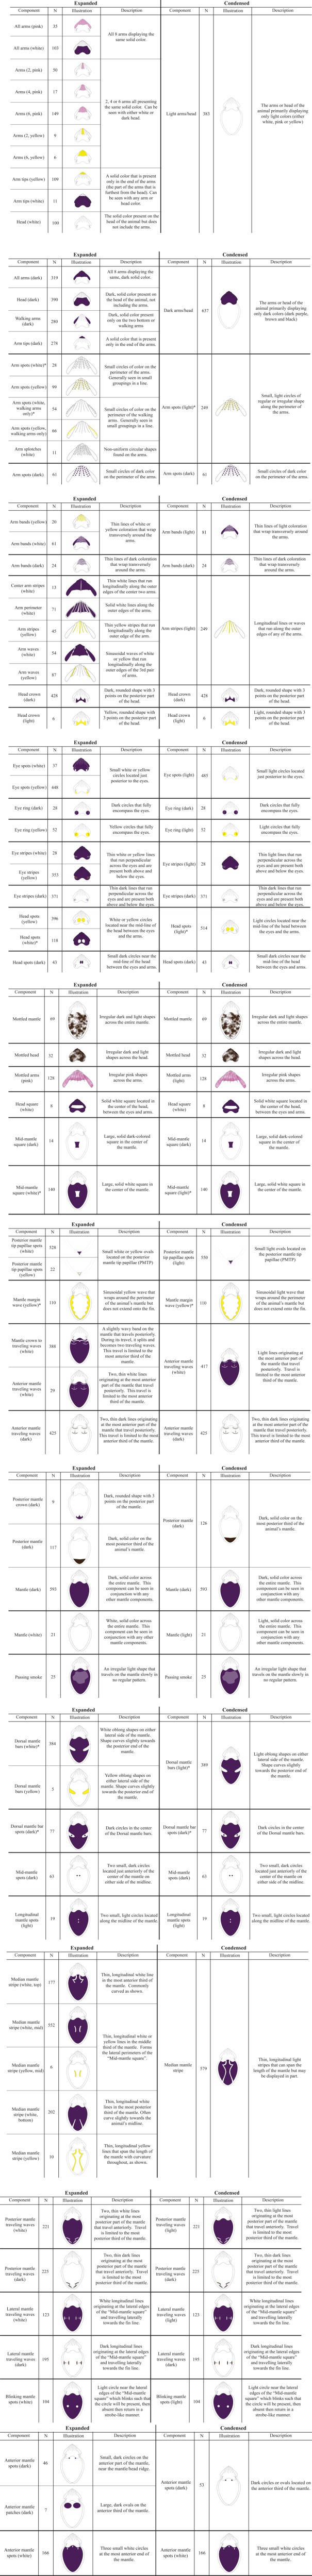
Comparison of the expanded and condensed lists of chromatic components.In this study, we provide both an Expanded List and a Condensed List of chromatic components for M. pfefferi (see ‘Methods’ for details). In the “Expanded” half of this figure, “Component” refers only to chromatic components as defined in the Methods: “Identifying Components” section. In the “Condensed” half of this figure, components from the Expanded List have been combined to reflect previously published ethograms of other species. N indicates the number of 1-s video clips that contained an animal displaying the specific component. All illustrations are taken directly from our Interactive Database and represent each component. For components on the arms or head, the mantle is not included in the illustration. White components are displayed on a dark background for visibility. Any arrows on the illustration indicate the direction and start and end locations for traveling components. The components on the Condensed List are displayed next to all of the Expanded components that were combined for its definition. For example, Dark arms/head on the Condensed List contains all of the All arms (dark), Head (dark), Walking arms (dark) and Arm tips (dark) components from the Expanded List. ∗, also identified by Roper & Hochberg (1988).